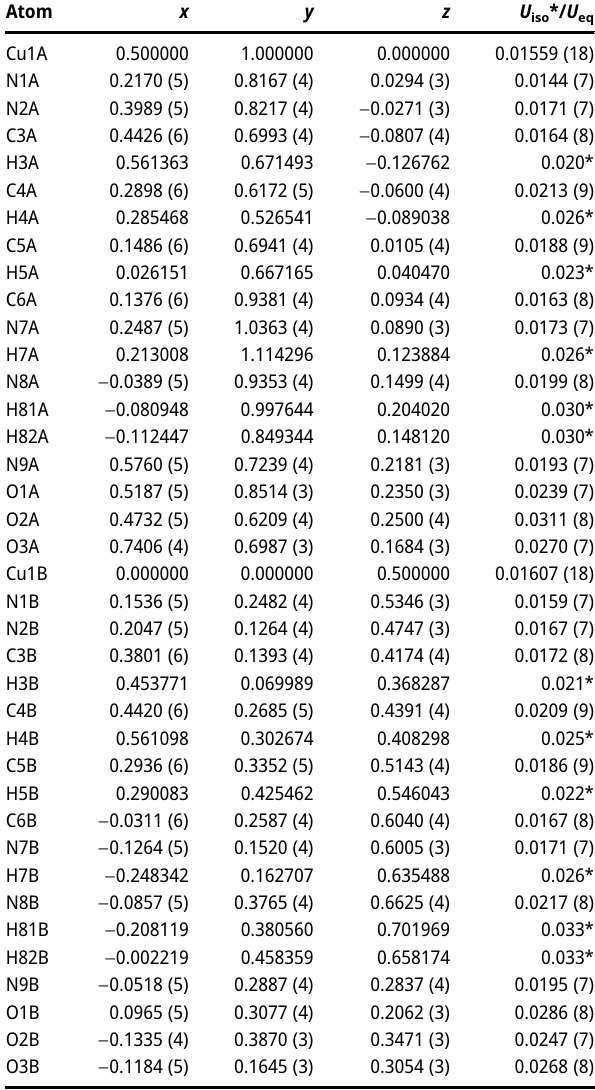
Table  : Fractional atomic coordinates and isotropic or equivalent isotropic displacement parameters (Å 